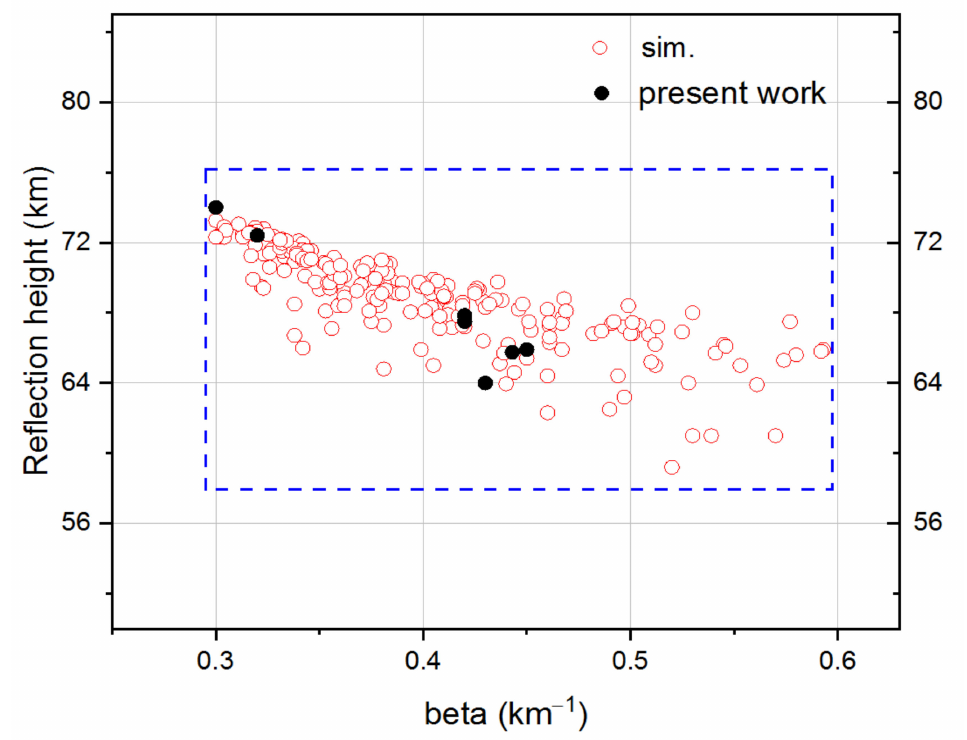
Figure 13. A scatter plot of a pair of D-region parameters, i.e., H (cid:48) versus β , is shown for SID cases analysed in this study using LWPC and two-component exponential model together with ones obtained using flared method from Github project